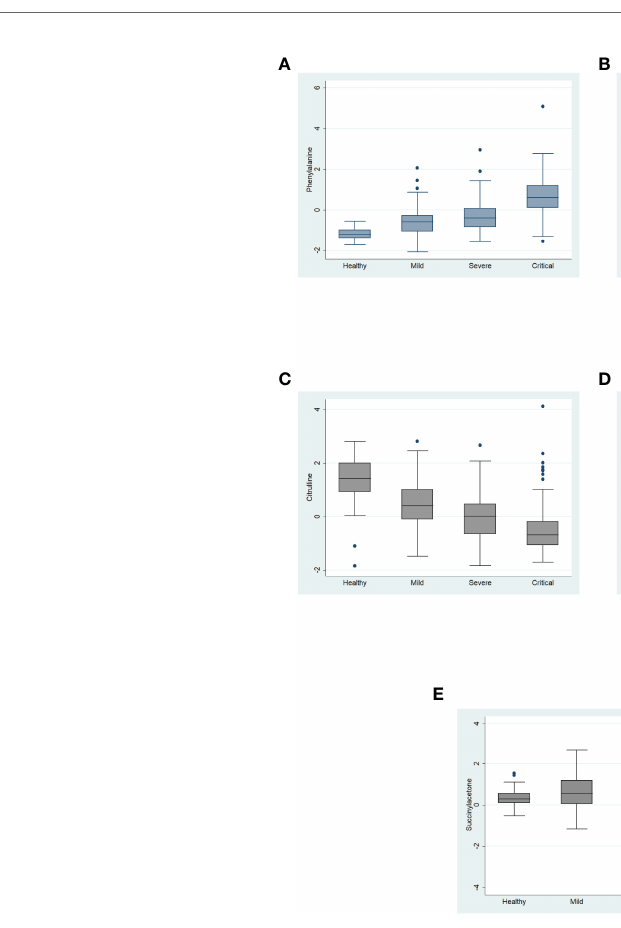
FIGURE 3 | Normalized serum concentrations of the fi ve metabolites with variable importance in projection of >1.5 from healthy subjects and patients with mild, severe, and critical COVID-19. Data are expressed as median with interquartile